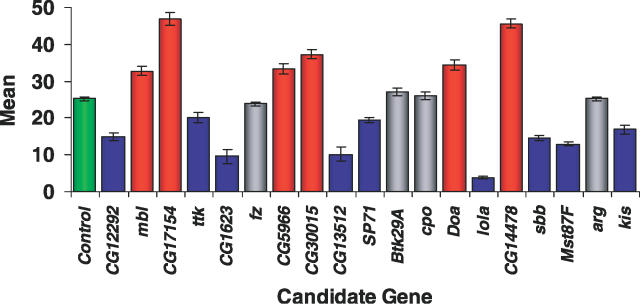
Mean Aggression Scores (±SE) of Lines Containing P-Element Insertional Mutations in Candidate GenesThe green bar denotes the Canton S B co-isogenic control line; grey bars indicate lines with scores not significantly different from the control; red bars indicate lines with significantly higher levels of aggression than the control; and blue bars indicate lines with significantly lower levels of aggression than the control.